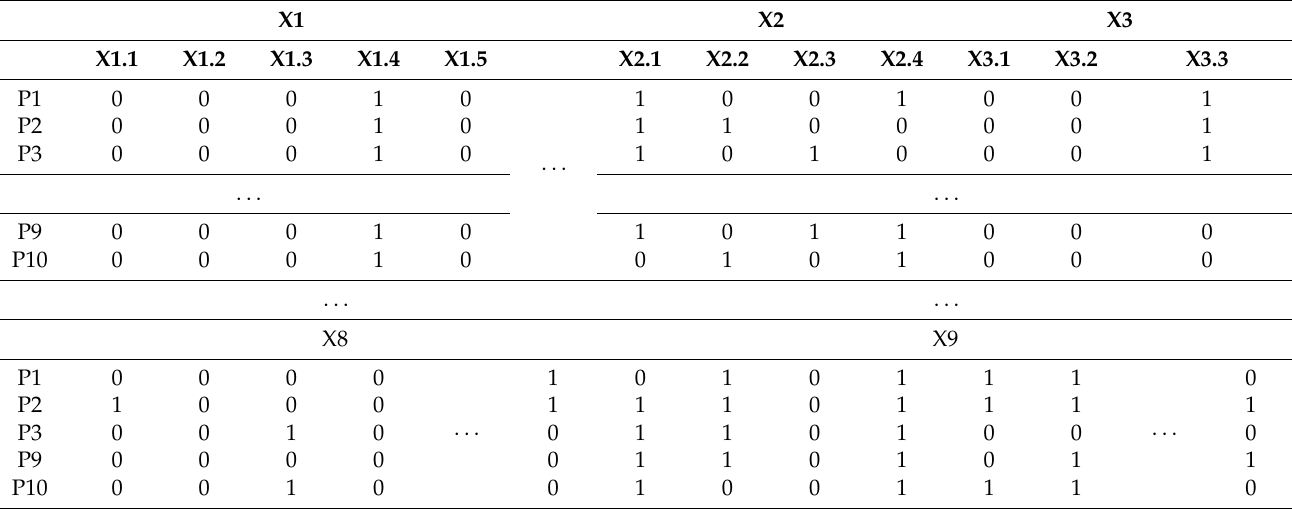
Table 6. Input–output policy